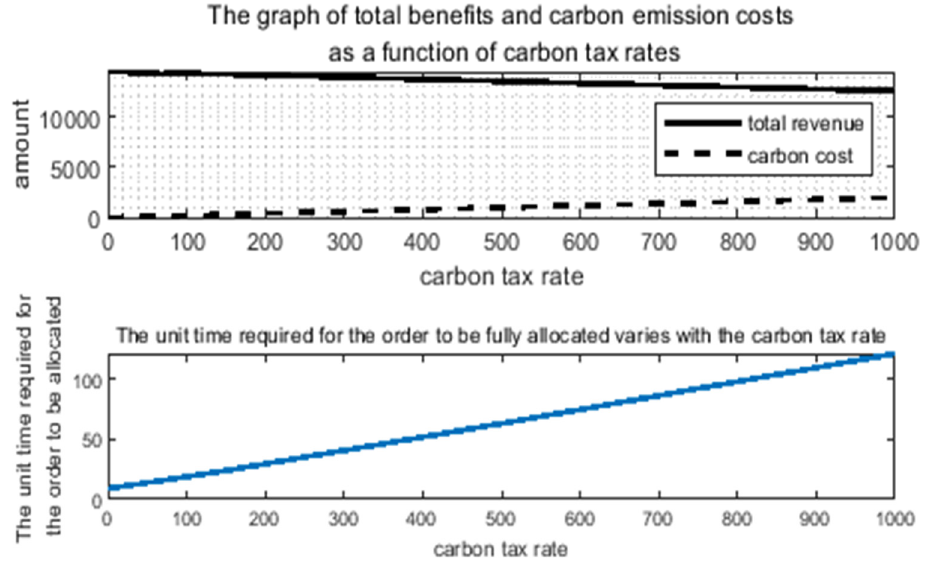
Figure 6. Changes in total benefits and carbon emission costs and order allocation time under the influence of carbon tax rates